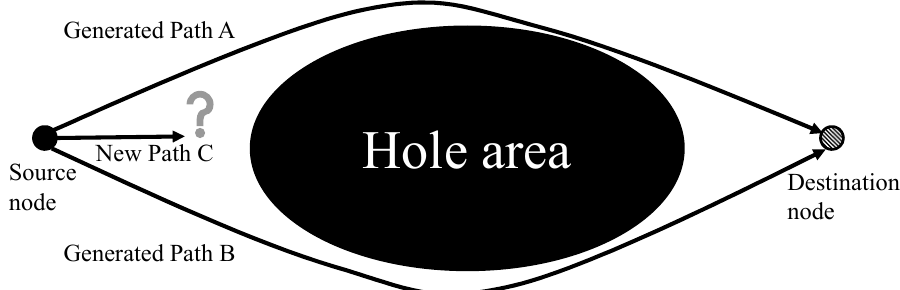
Figure 4. The isolated problem near the hole area during the multipath